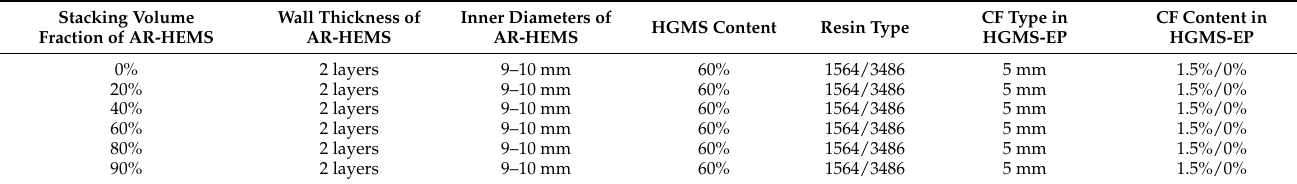
Table 1. 12 samples of ESF filled with AR-HEMS with different stacking volume fractions.